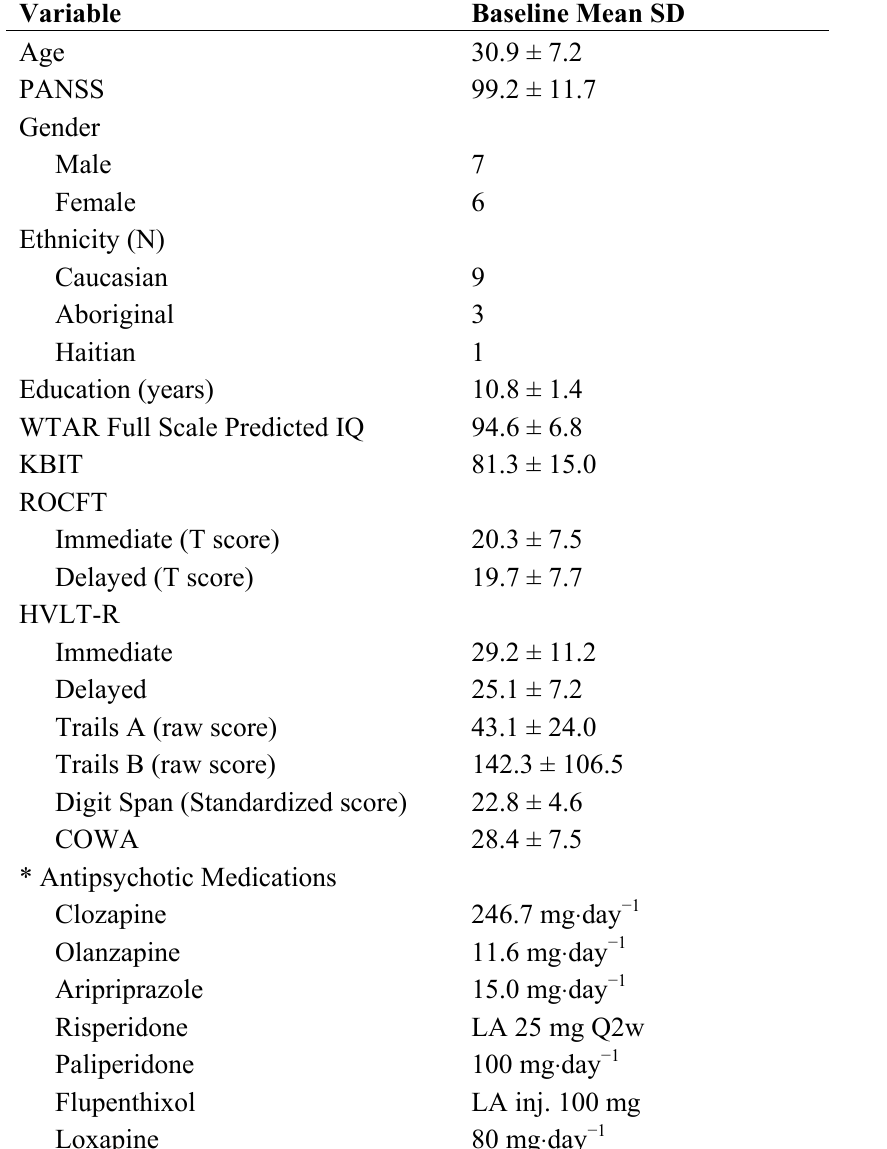
Table 4. Clinical and Demographic Data (mean ±